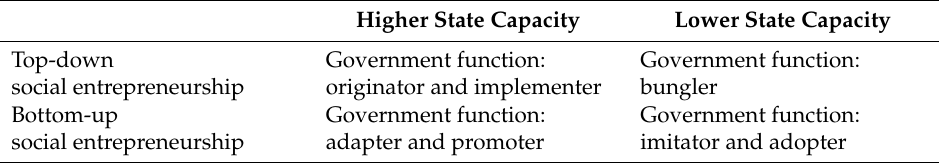
Table 1. The functions of government in social entrepreneurship